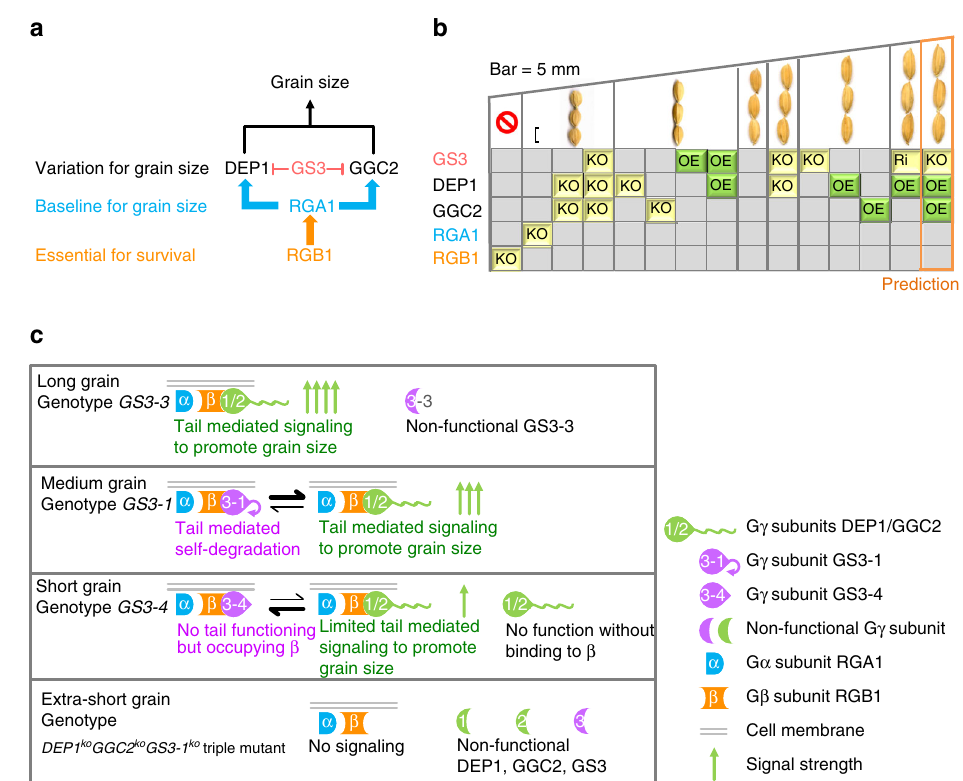
Fig. 3 Schematic representation of the functions of the G proteins in grain size regulation. a A genetic model depicting the pathway of the G proteins in grain size regulation. The black arrow indicates positive effect, and the red bars represent negative effect. b Manipulating grain size by combinations of G proteins. KO indicates knocking out of the gene, Ri for RNAi plants, and OE for overexpression of the gene. The empty space indicates wild type. c A model explaining how these G γ proteins